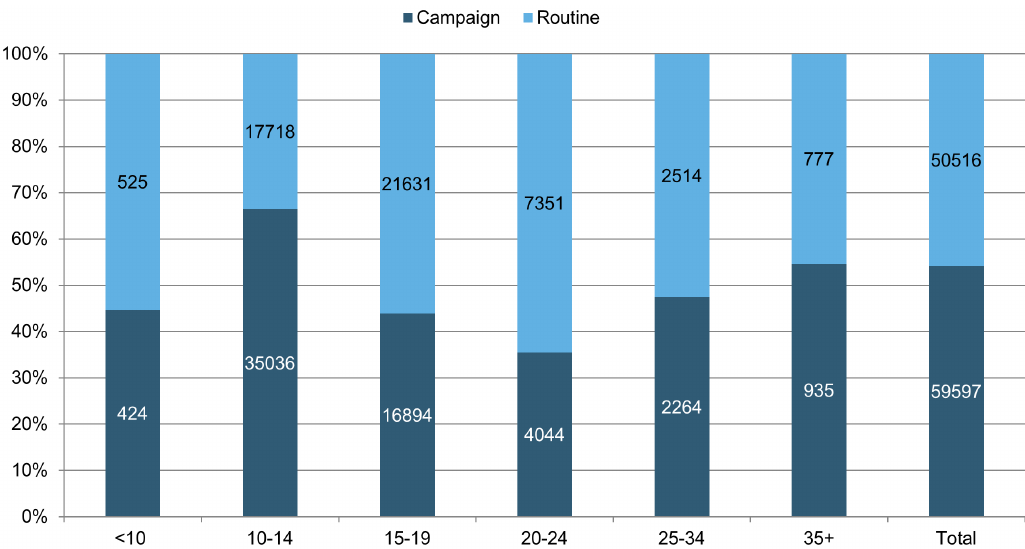
Figure 6. Percentage distribution of VMMC procedures by intensity (campaign vs. routine), in Iringa and Njombe regions, Tanzania, October 2009 to December 2012.